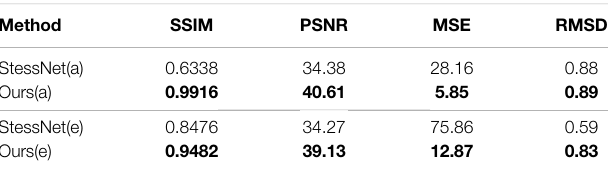
TABLE 4 | Quantitative results of comparison with StressNet (Briñez de León et al., 2020b). (a) and (e) represent the results of processing the photoelastic fringes in Figure 5